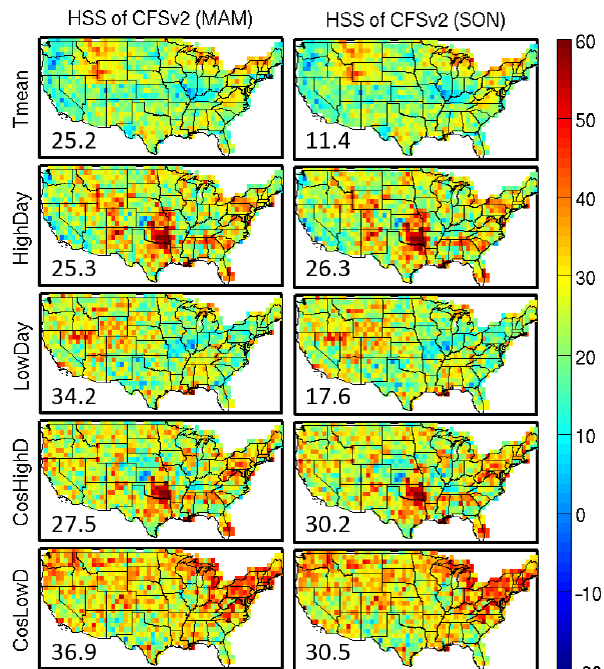
Figure 7. Same as in Fig. 6, but for MAM and